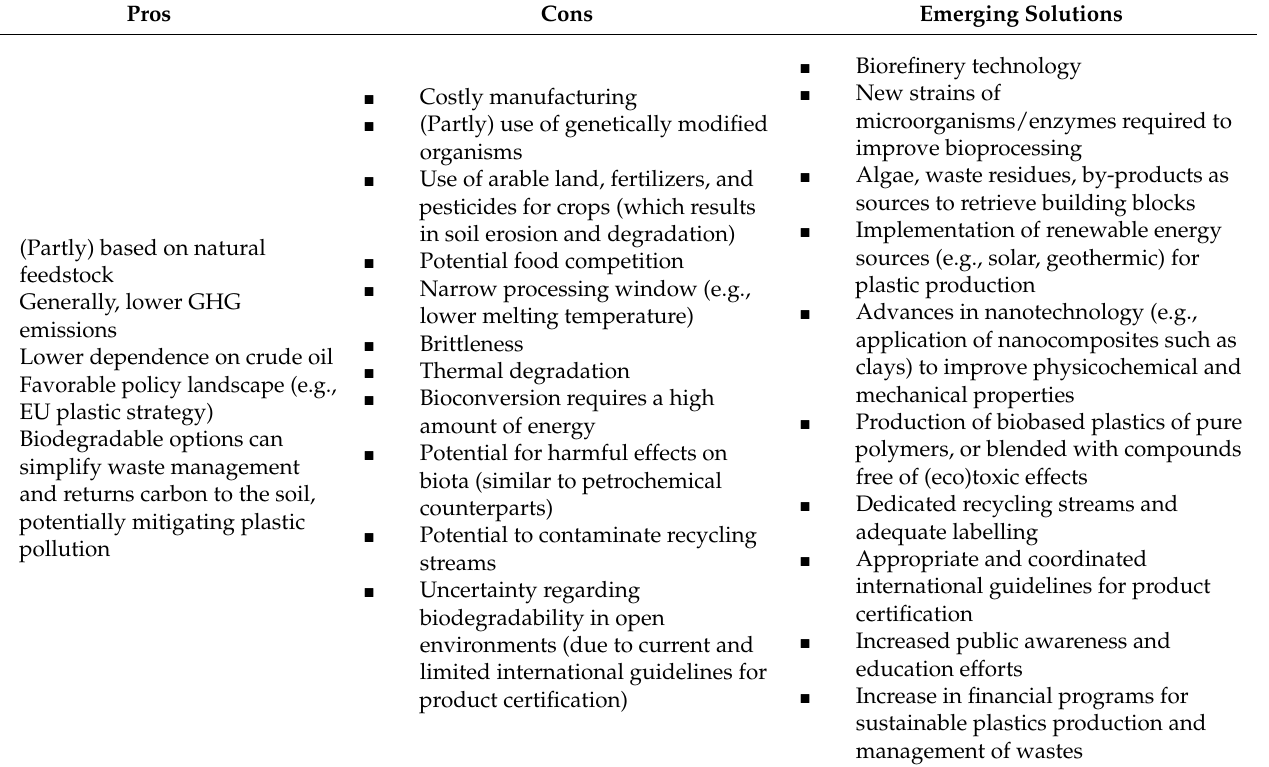
Table 2. Summary of pros, cons, and emerging solutions regarding biobased plastics (from cradle to crate). Pros Cons Emerging